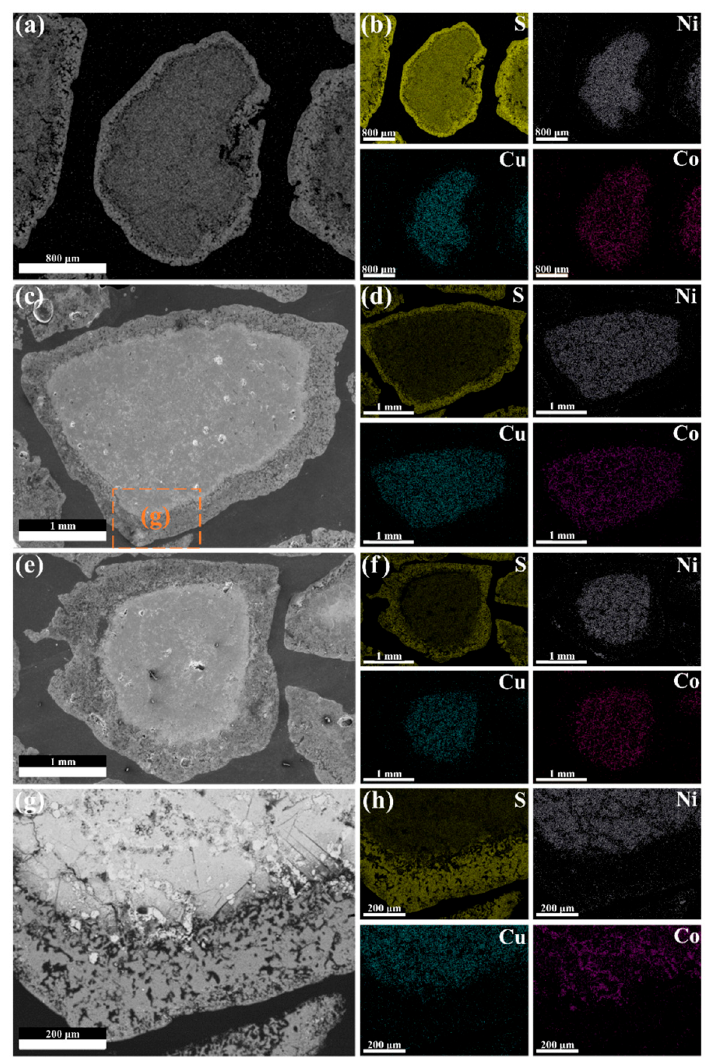
Figure 4. ( a , c , e ) SEM images of the low-nickel matte after 1, 2, and 3 h mechanical agitation leaching, respectively; ( b , d , f ) EDS analyses for the selective areas from ( a , c , e ), respectively; ( g ) local enlarged SEM image of ( c ); ( h ) EDS analyses for the selective areas from ( g ).